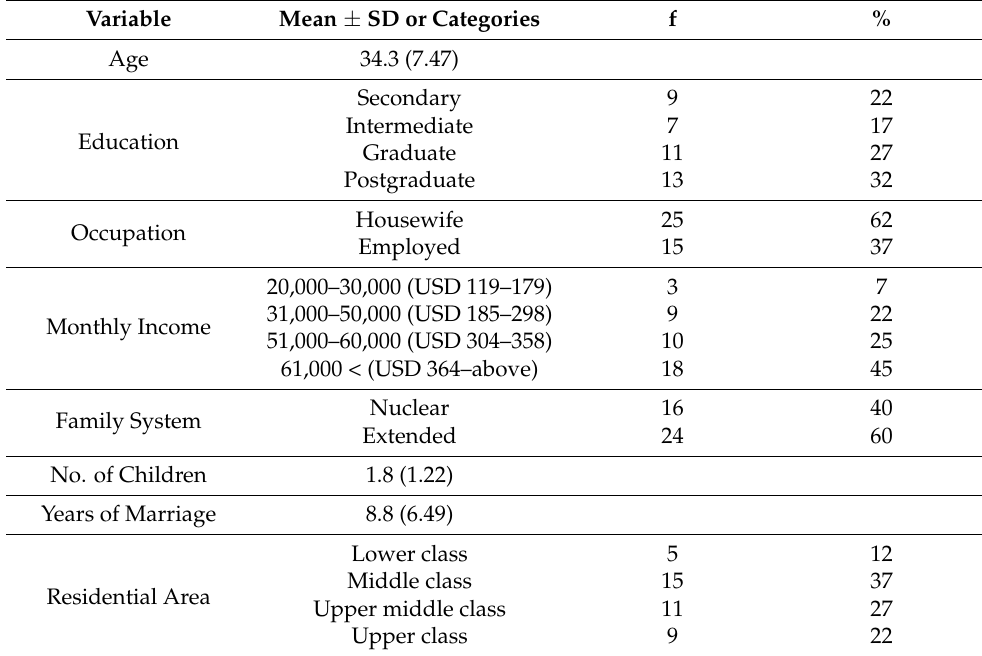
Table 1. Frequencies (f) and percentages (%), or mean and standard deviation for demographic characteristics of participants (N = 40).